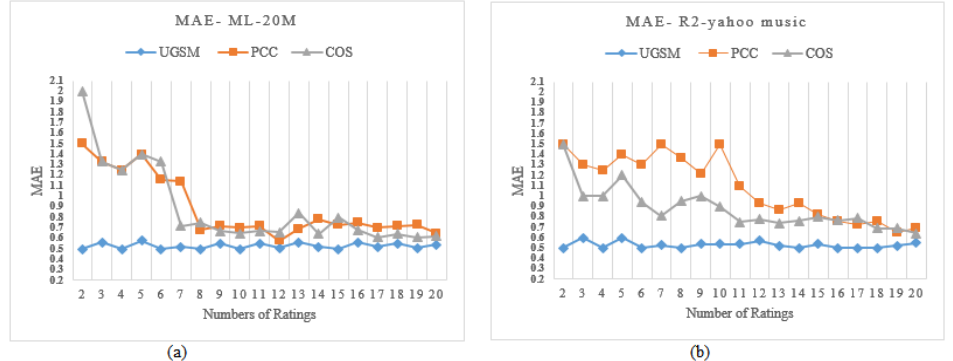
Figure 9. MAE for ( a ) ML-20M dataset and ( b ) R2-Yahoo music dataset. The X -axis is the number of ratings and the Y -axis is the MAE value.